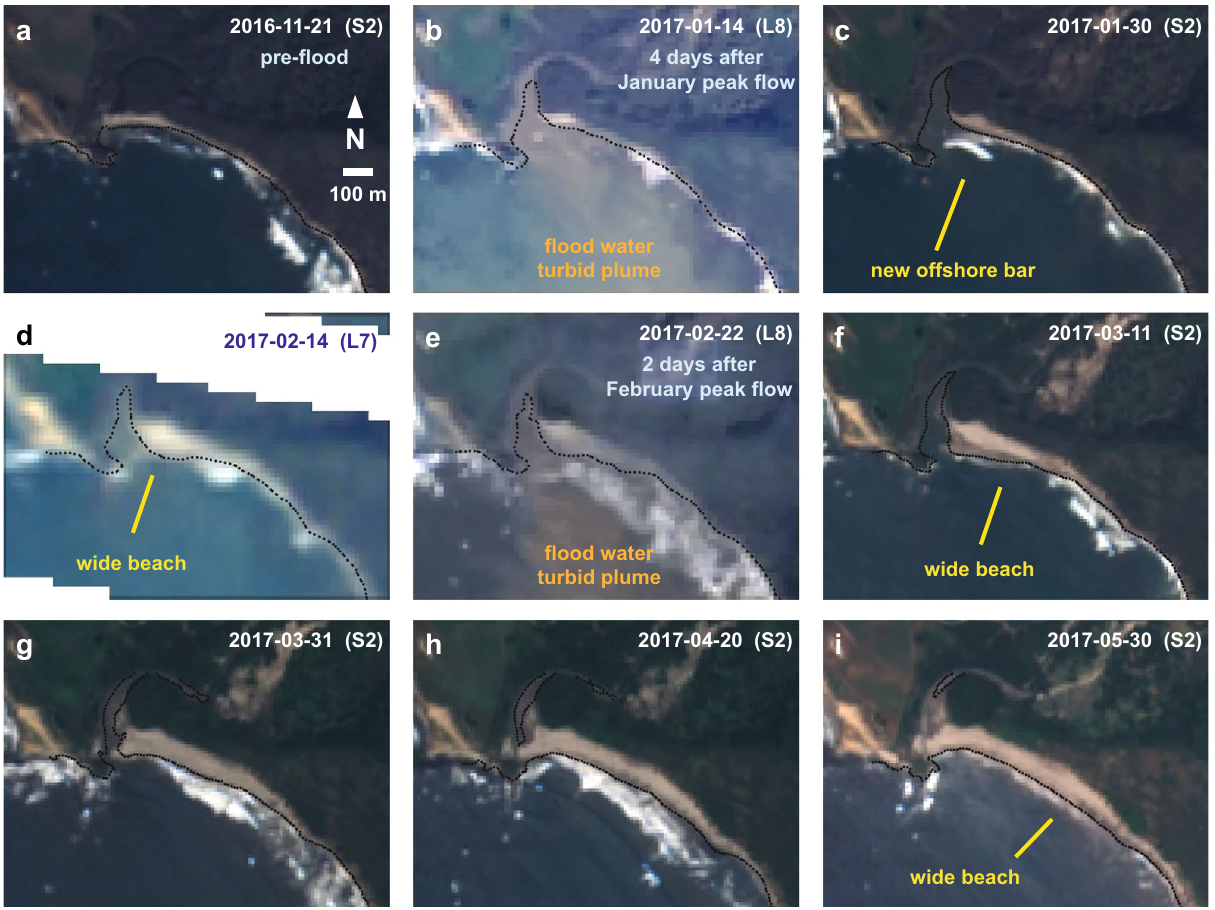
Figure 5. Sentinel-2 (S2) and Landsat (L7 and L8) imagery of the Big Sur River mouth highlighting coastal changes from river sediment contributions during the winter and spring of 2016–2017. Images are top-of- atmosphere true color (RGB) products and include the mapped shoreline position from the CoastSat algorithms (black lines). Imagery was extracted for areas bounding 36.2762° N to 36.2845° N latitude and − 121.8497° to − 121.8609° longitude. The image from Landsat-7 shown in ( d ) include scanline errors that are shown as no data (white areas). Imagery were obtained through Google Earth Engine (https:// earth engine. google. com/) using the CoastSat tool box version 1.1.2 (https:// github. com/ kvos/ Coast Sat) and assembled in Abobe Illustrator version